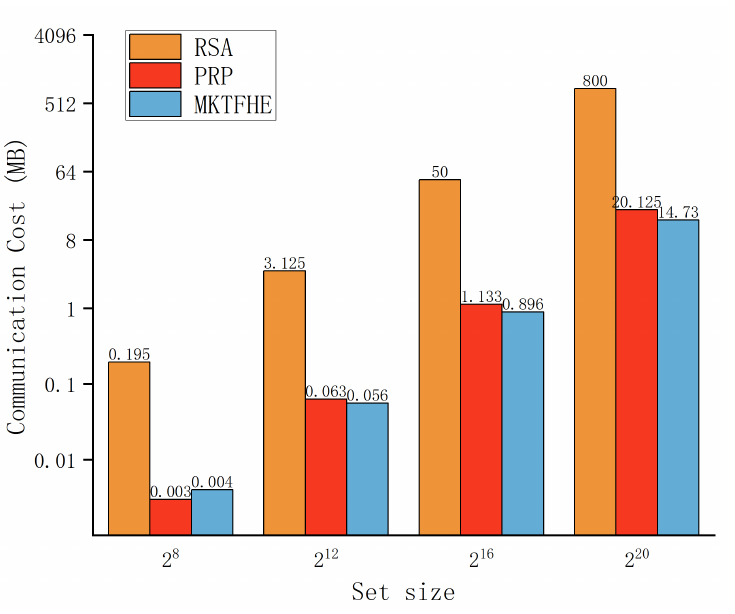
Figure 5. Communication